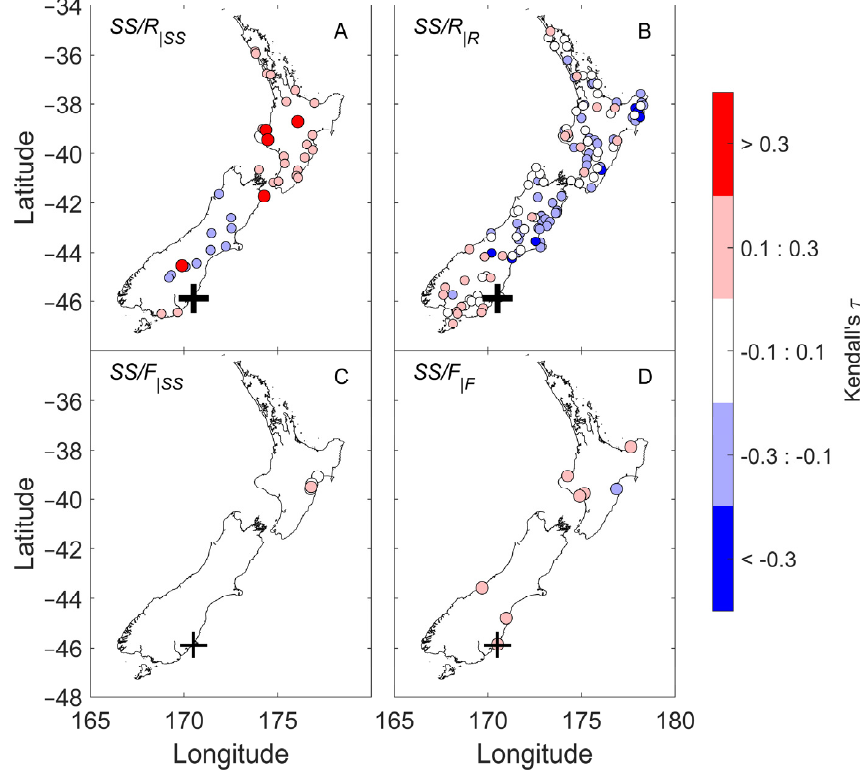
Figure 8. Kendall’s rank correlation coefficient τ (color scale) calculated between skew-surge measured at Dunedin and individual rainfall and river-flow records. ( A ) τ for skew-surge and rainfall, with rainfall conditional on extreme skew-surge; ( B ) τ for skew-surge and rainfall, with skew-surge conditional on extreme rainfall, ( C ) τ for skew-surge and river-flow, with river-flow conditional on extreme skew-surge, ( D ) τ for skew-surge and river-flow, with skew-surge conditional on extreme river-flow.